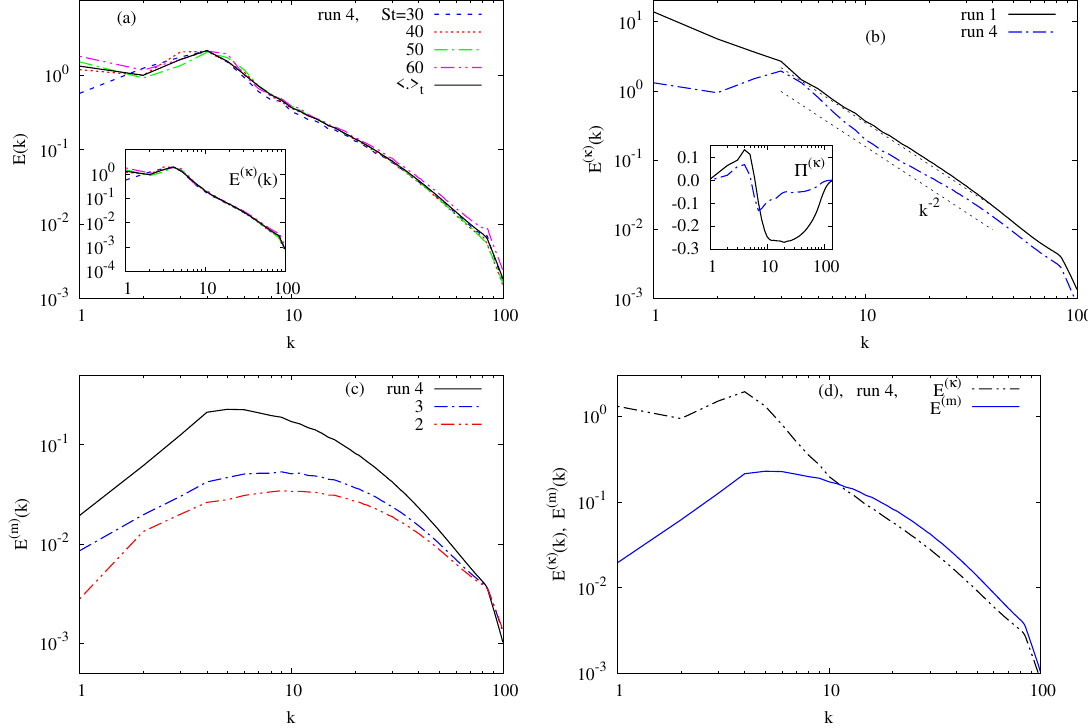
Figure 8. ( a ) Radial spectra of total (kinetic + magnetic) energy at different dimensionless time St = 30, 40, 50, 60 and their average (cid:104) E ( k , t ) (cid:105) t over the time window St ∈ [ 25,65 ] for run 4. The development of kinetic energy at these different times and its average over the same time window (cid:104) E ( κ ) ( k , t ) (cid:105) t is reported in the inset. ( b ) Radial spectrum (cid:104) E ( κ ) ( k , t ) (cid:105) t for runs 1 and 4. The inset shows the spectral energy flux (cid:104) Π ( κ ) ( k , t ) (cid:105) t normalized by the kinetic energy (cid:104) E ( κ ) ( t ) (cid:105) t for the same runs. In Figure 8b the dashed straight line, which indicates the k − 2 scaling, delimits the range k S = 4 ≤ k ≤ k Ω = 40. ( c ) Radial spectra of magnetic energy for runs 2–4. ( d ) Comparison between E ( κ ) ( k ) and E ( m ) ( k ) for run